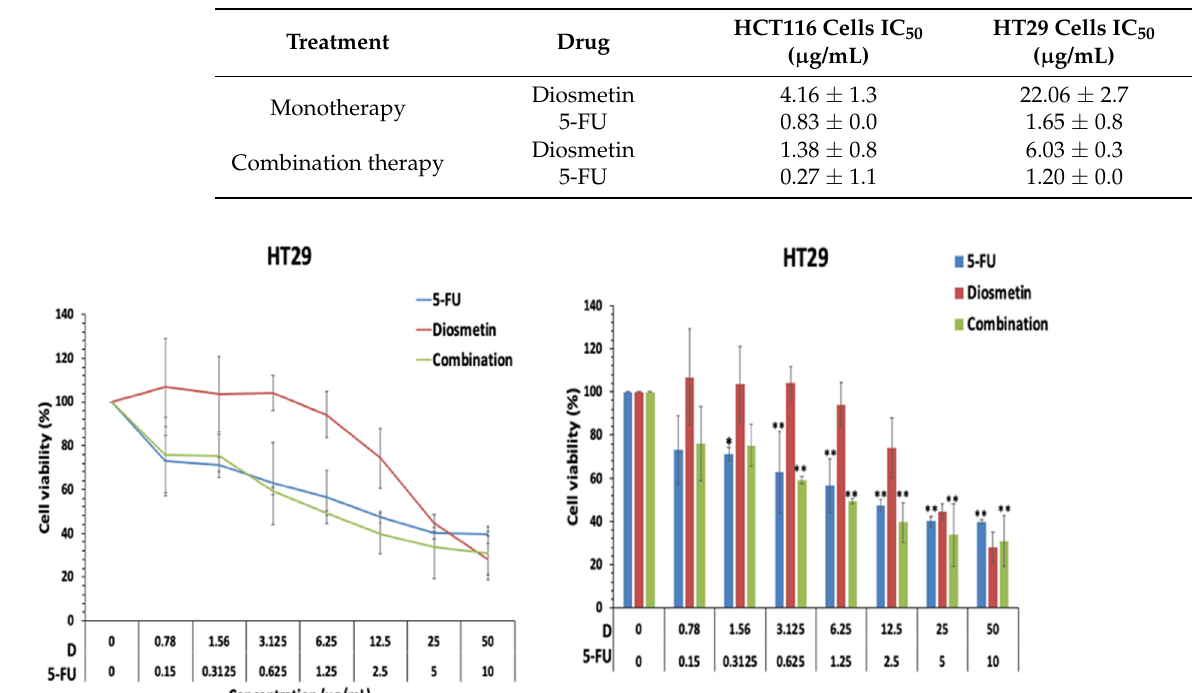
Figure 4. Cell growth inhibitory effect of diosmetin (D) and 5-FU as monotherapy and combination therapy in HT29 cells. Data were expressed as mean ± standard deviation (SD). * p < 0.05 and ** p < 0.01 indicate significant differences compared with the untreated control (0).